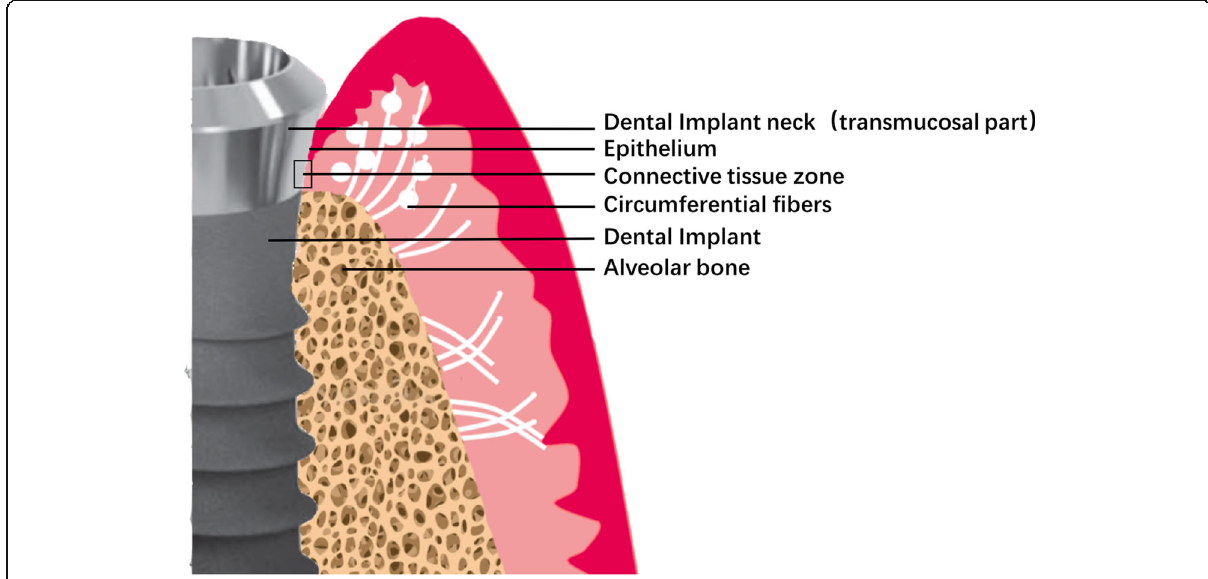
Fig. 1 Schematic illustration of soft tissue implant integration. The gingival fibers in a parallel orientation on implant